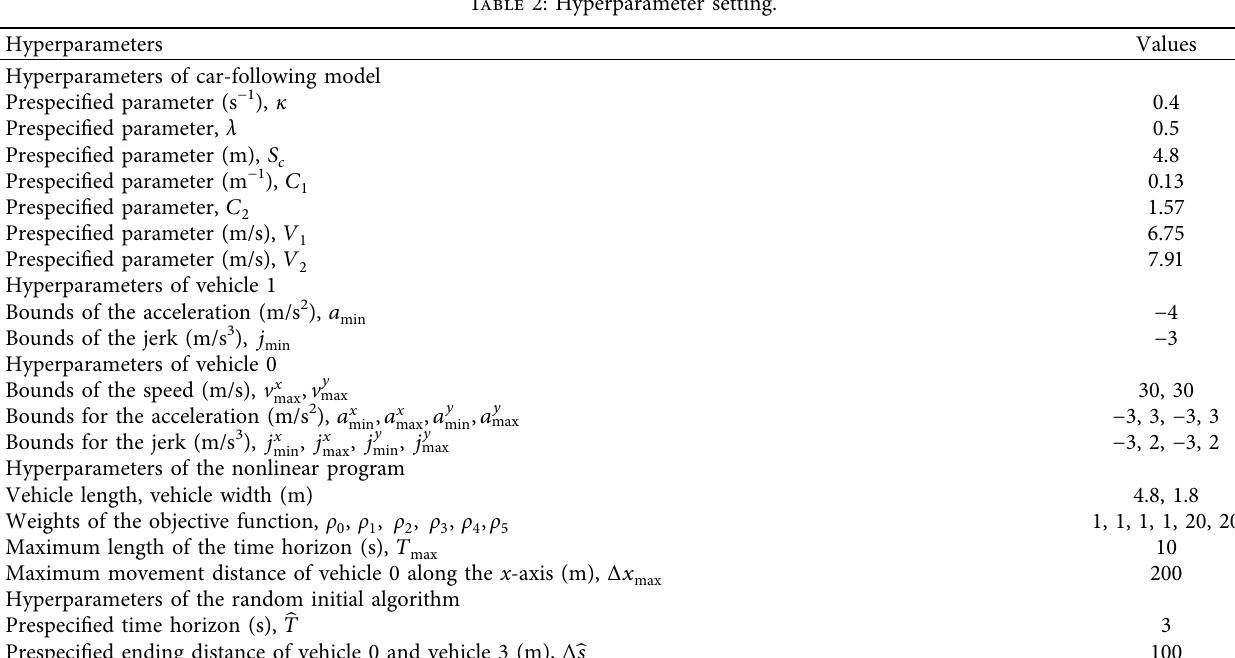
Table 2: Hyperparameter setting.